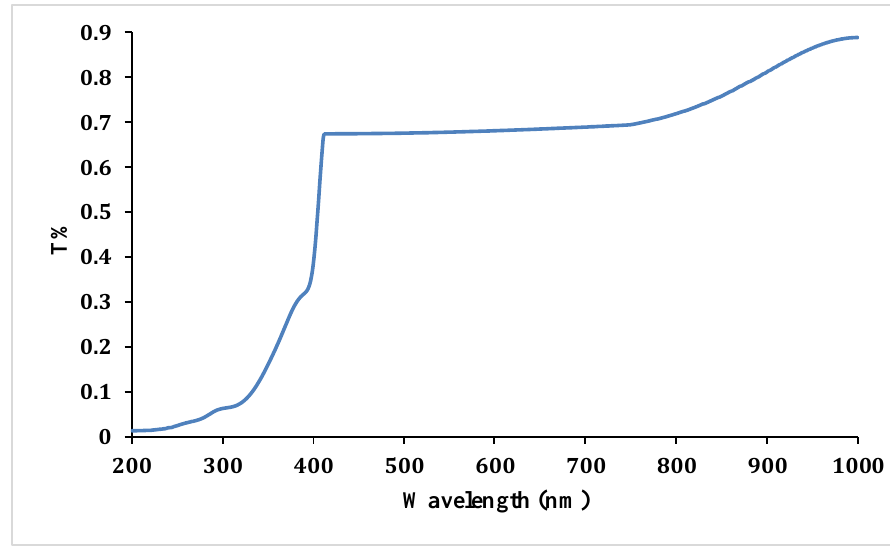
Figure 8 : The transmission spectrum of PbI2 films deposited on glass substrate by thermal evaporation Tauc plot was used to analyze the optical band gap. Figure 9 depicts a linear relationship between (αhv) 2 and photon energy. This behavior indicates that a direct permitted transition is possible in the PbI2 film. From the linear part of the curve to the photon energy axis, the optical band gap can be extracted [15]. For PbI 2 thin film, the extrapolation yielded a band gap of 2.65 eV. The energy gap was calculated by using Eq. (2):